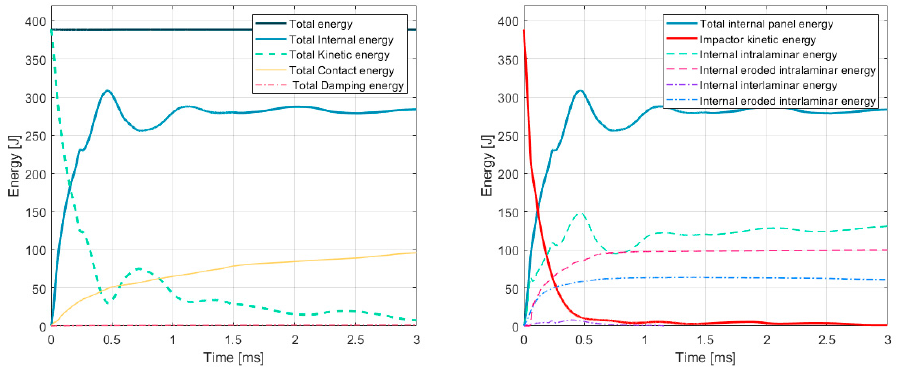
Figure 9. SX—energy conservation of the global FE solution. DX—internal energy distribution between intralaminar and interlaminar